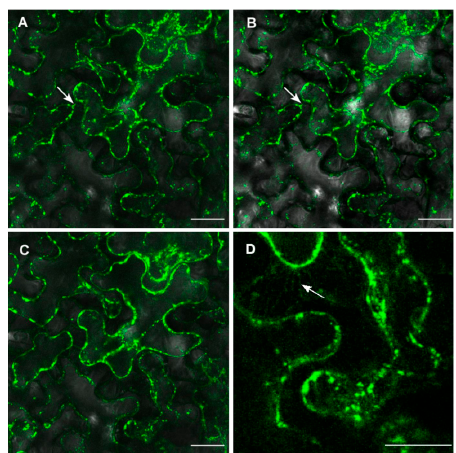
Figure 5. Cellular localization of ZosmaNRT2 transiently expressed in N. benthamiana leaves. Confocal images of epidermal leaf cells coexpressing 35S::ZosmaNRT2-GFP and 35S::ZosmaNAR2 were taken after 25 min ( A ), 26 min ( B ), and 28 min ( C ) and ( D ) of 0.8 M Mannitol treatment. Arrows indicate the GFP signal in the Hechtian-strands of the plasma membrane. Images are representative of ten independent trials. Bars: 25 µm ( A – C ) and 10 µm ( D ).